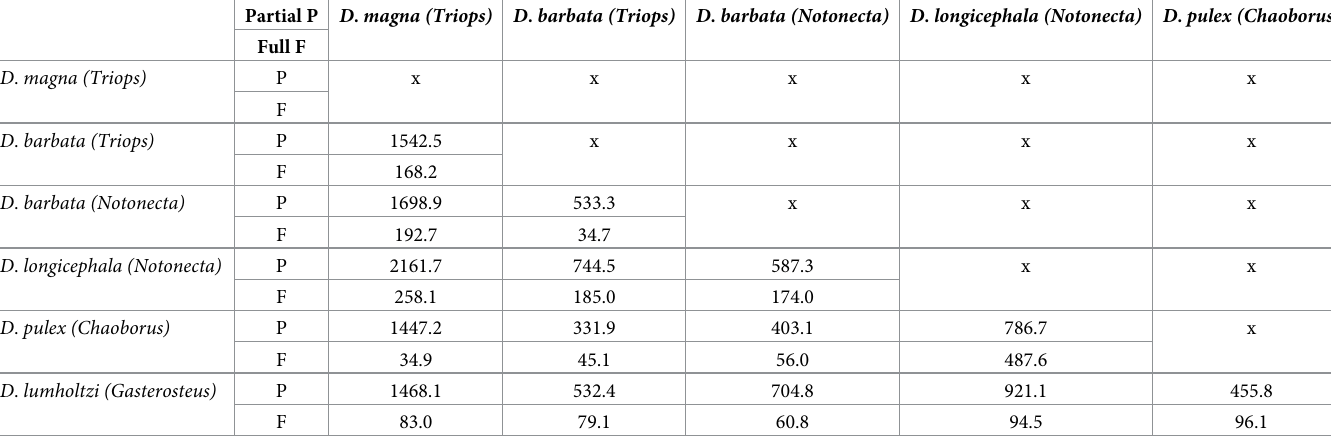
Table 2. Average partial and full Procrustes distances between